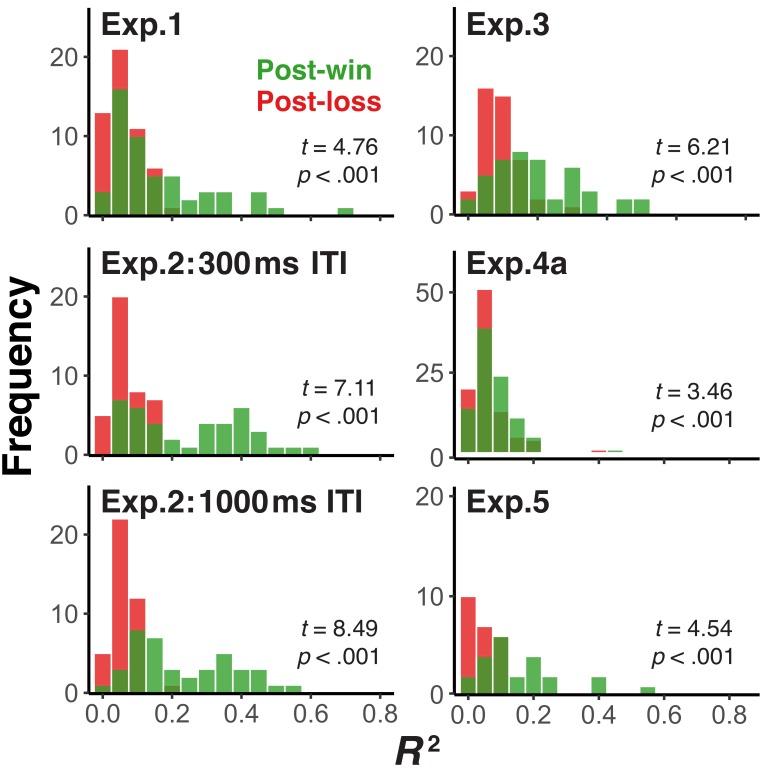
Alternative analysis of history effects.Aside from history analyses presented in Figure 4, we also conducted a more straightforward assessment of the effect of history on switch/repeat choices that did not require selective recoding of predictors. Specifically, we performed individual, logistic regression analyses for each subject, and separately for post-win and post-loss trials. Given that the effect of overall switch context was already demonstrated in our initial analyses (see Figure 2), we only included here the players’ and the opponents’ trial n-1 to n-3 switch/repeat choices as predictors. This figure supplement shows for each experiment the histograms of Cox and Snell pseudo R2-square scores from logistic regression models fitted within subjects (dark green shading indicates overlapping regions of the distributions). The difference in fit scores between post-win/loss was tested via t-test after converting R2 values into z-score (Cox, 2018). As apparent, post-win distributions were in all cases significantly farther to the right than post-loss distributions. Thus, these analyses confirm that following wins, switch/no-switch decisions are overall more dependent on history than post-loss decisions.